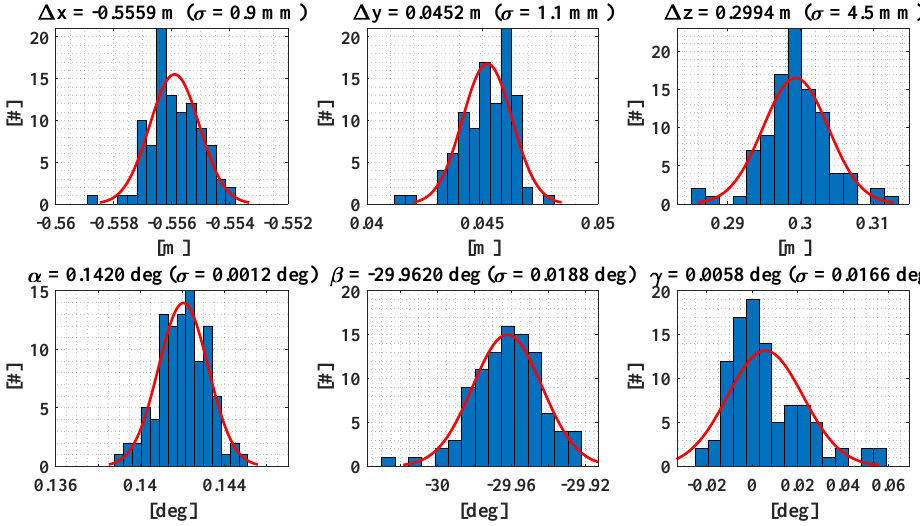
Figure 10. Results of the 98 calibration runs: Lever arm components ∆ x , ∆ y , and ∆ z ( top row ), boresight angles α , β , and γ ( bottom row ). The mean values and standard deviations σ are stated on the top of the histograms. For comparison, an ideal Gaussian distribution is added to the plots.